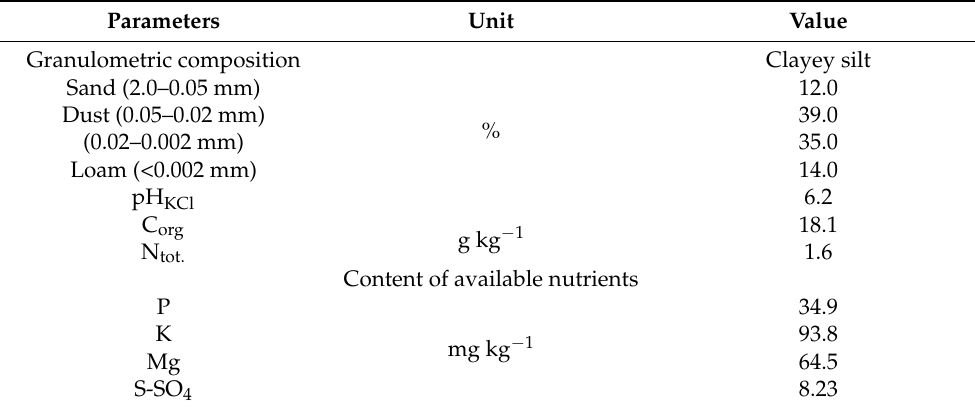
Table 1. Selected soil properties (0–30 cm depth) before setting up the experiment (2010).